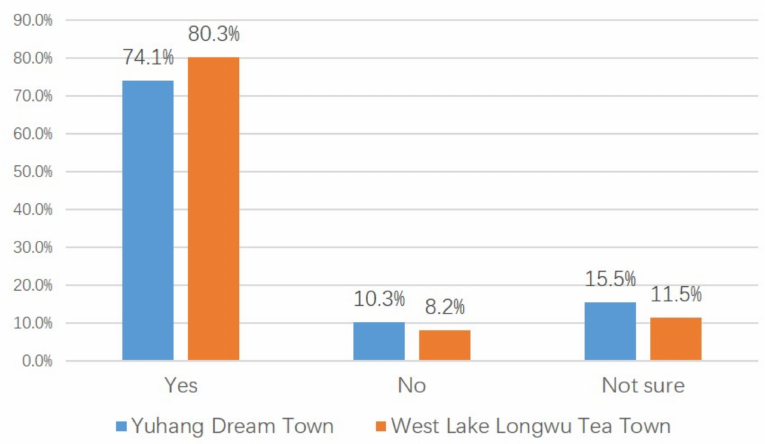
Figure 33. Respondents’ opinions on whether local development benefits from the local CT practice (source: